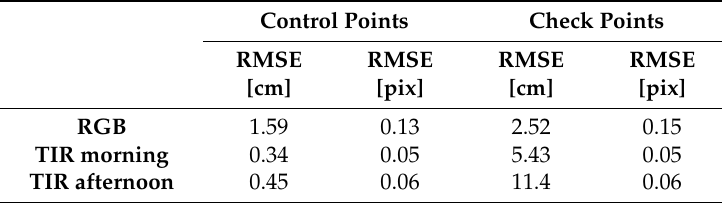
Table 4. Statistics of Ground Control Points (GCPs) and Check Points (CPs) for RGB and TIR photogrammetric projects provided by Agisoft